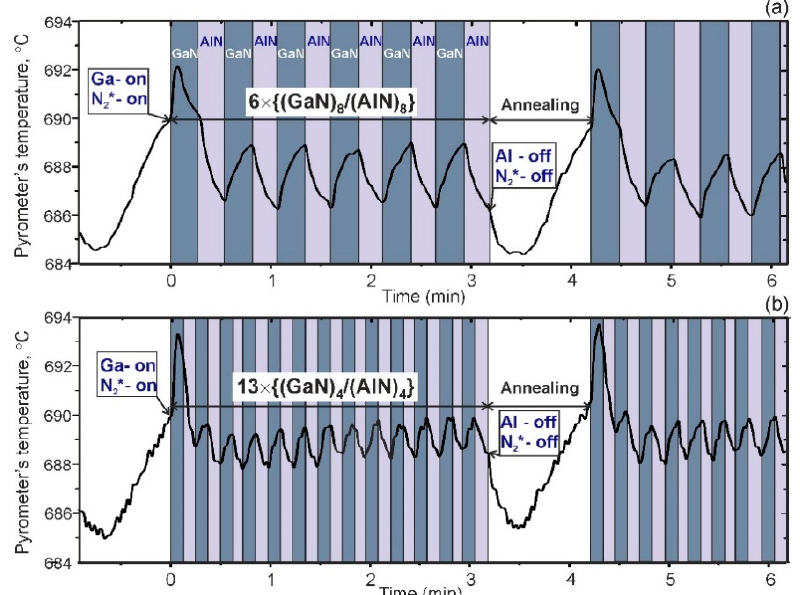
Figure 1. Temporal evolutions of the IR-pyrometer readouts during the growth of 42 × 6 × {(GaN) 8 /(AlN) 8 } ( a ) and 44 × 13 × {(GaN) 4 /(AlN) 4 } ( b ) SLs with the same growth parameters and the same duration of short-term annealing after growth of every six and thirteen SL periods,